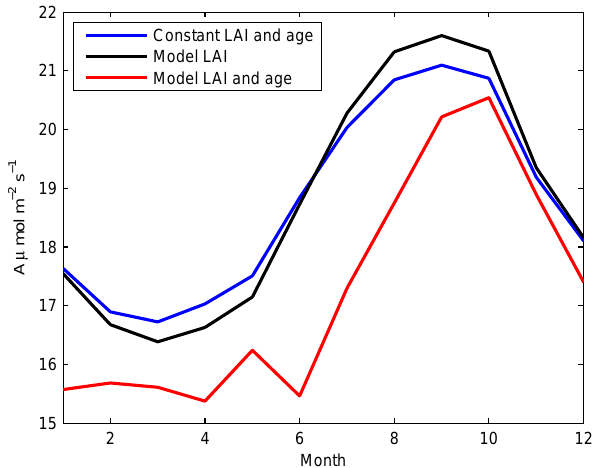
Fig. 9. Gross carbon assimilation calculated using a simple carbon model for a constant LAI, model LAI and model LAI including the temporal variations in leaf age. The values presented are monthly means over a 5 year period at one location (8 ◦ N 55 ◦ W). All values are µmolm − 1 s − 1